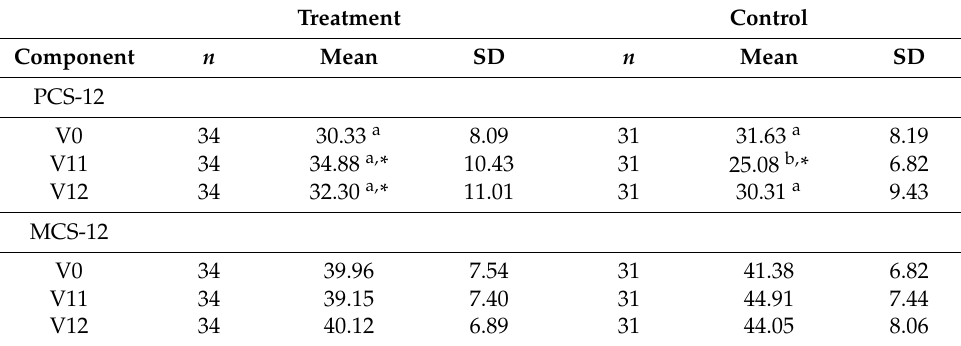
Table 7. Questionnaire SF-12 on the State of